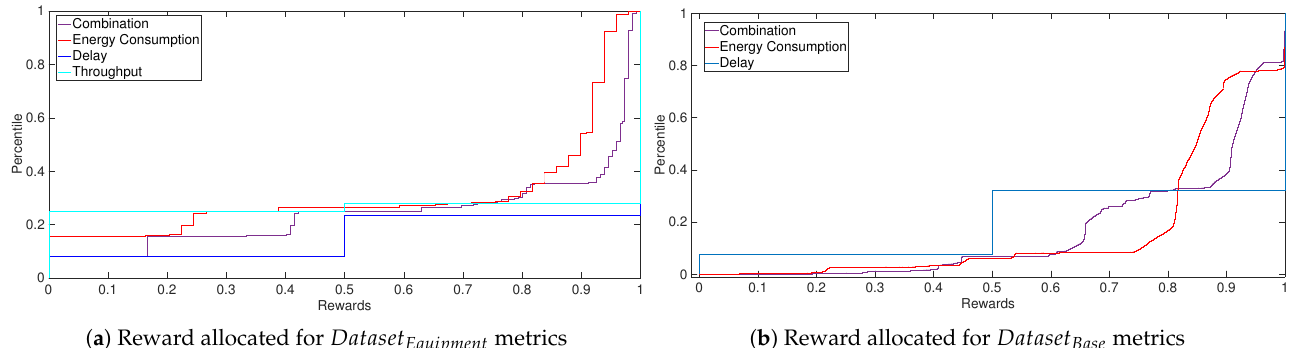
Figure 5. ECDF of rewards for single and combined performance metric suggestion for Dataset Base and Dataset Equipment utilising the most optimal RL individual with Genetic Algorithm.